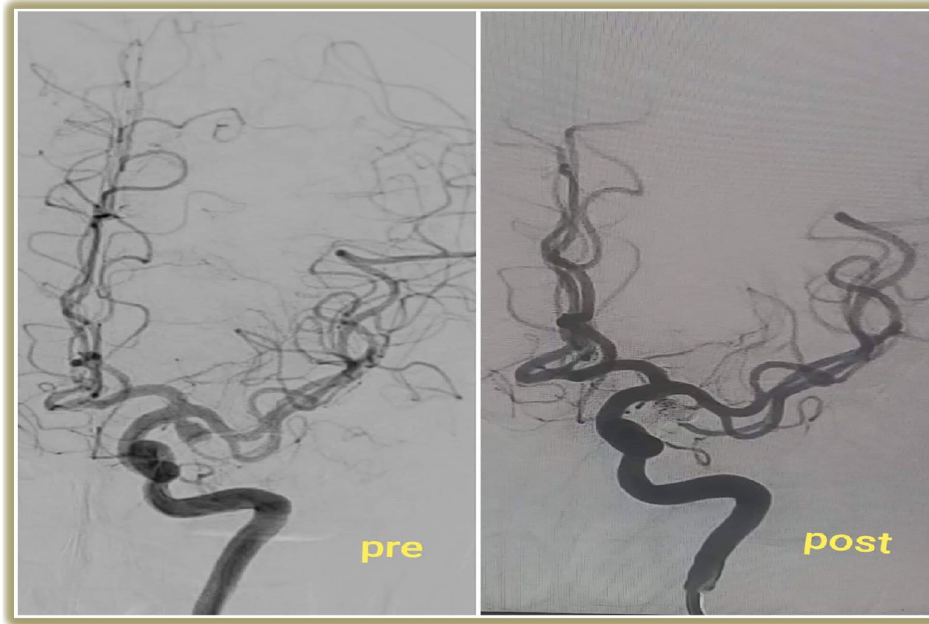
Fig. 3 DSA, left internal carotid aneurysm (anteroposterior view) showing prebifurcational aneurysm pre and post coil